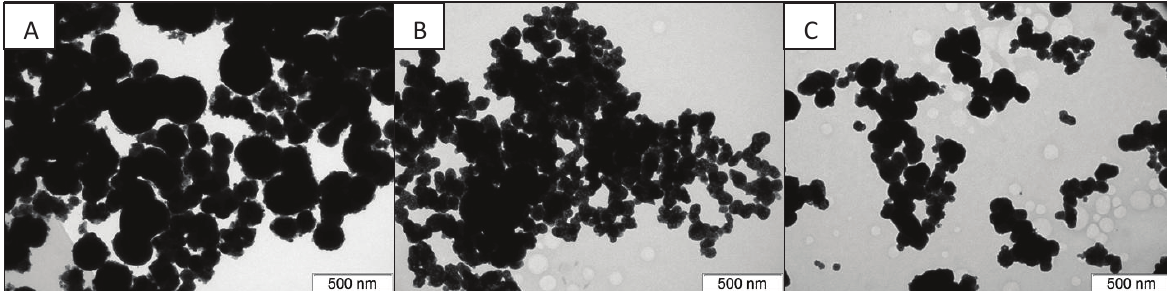
Figure 3: TEM images of the initial Ce-Zr supports: A - B1, B – B2, C – Ch. Table 2: Average sizes of Ni-containing particles by TEM and XRD. Specific surface areas of the oxide supports and catalysts are presented in Table 1.